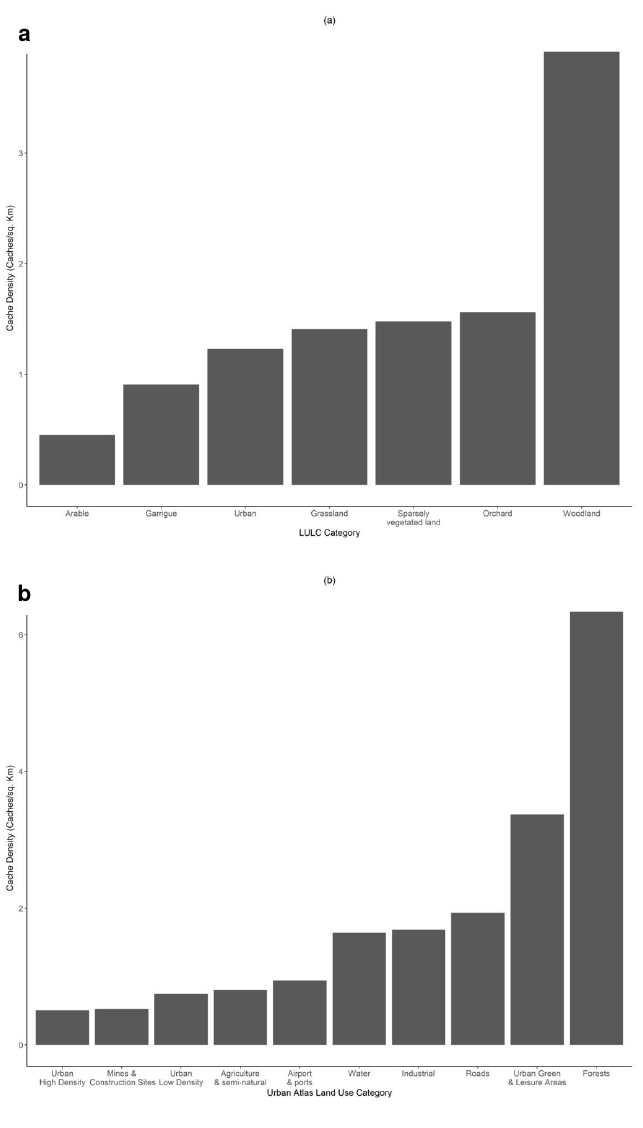
Figure 3. Relationship between cache density and the land use and land cover when using (a) a land use land cover (LULC) map generated using Sentinel 2 satellite images and (b) the EEA urban atlas land uses for the study area. a : Relationship between cache density and the land use and land cover when using the land use land cover (LULC) map generated using Sentinel 2 satellite images b : Relationship between cache density and the land use and land cover when using the EEA urban atlas land uses for the study